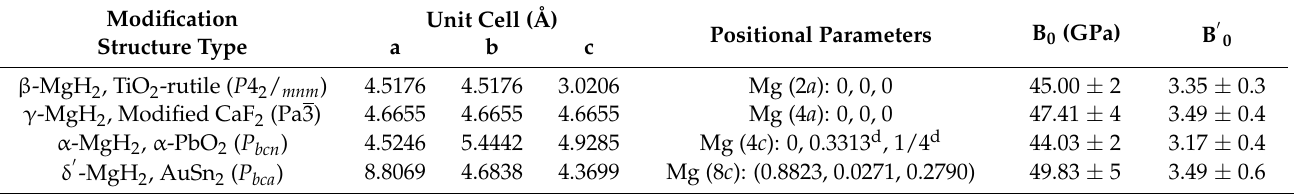
Table 1. Optimized structural parameters, bulk modulus (B 0 ), and pressure derivative of bulk modulus (B ’ 0 ) for MgH 2 in ambient and high-pressure phases. (Reprinted with permission from ref. [22]. Copyright 2006 American Physical Society.) Modification Unit Cell (Å) Positional Parameters B 0 (GPa) B (cid:48) 0 Structure